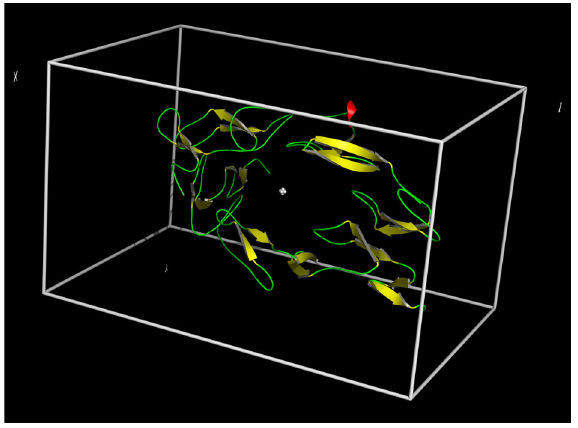
Figure 1. 3D structure of TNFR1 with gridbox used for docking simulations. TNFR: tumor necrosis factor